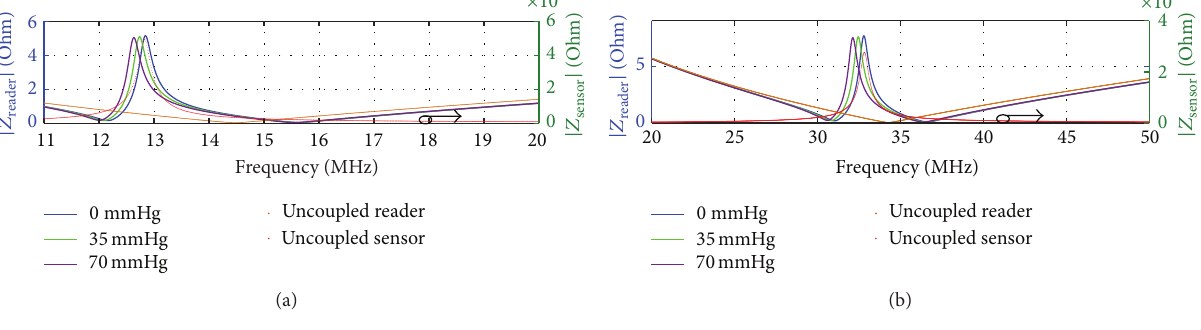
Figure 3: Simulated impedance of the reader antenna and implantable sensors at different pressures. The simulation results for sensor A and sensor B are shown in (a) and (b), respectively.